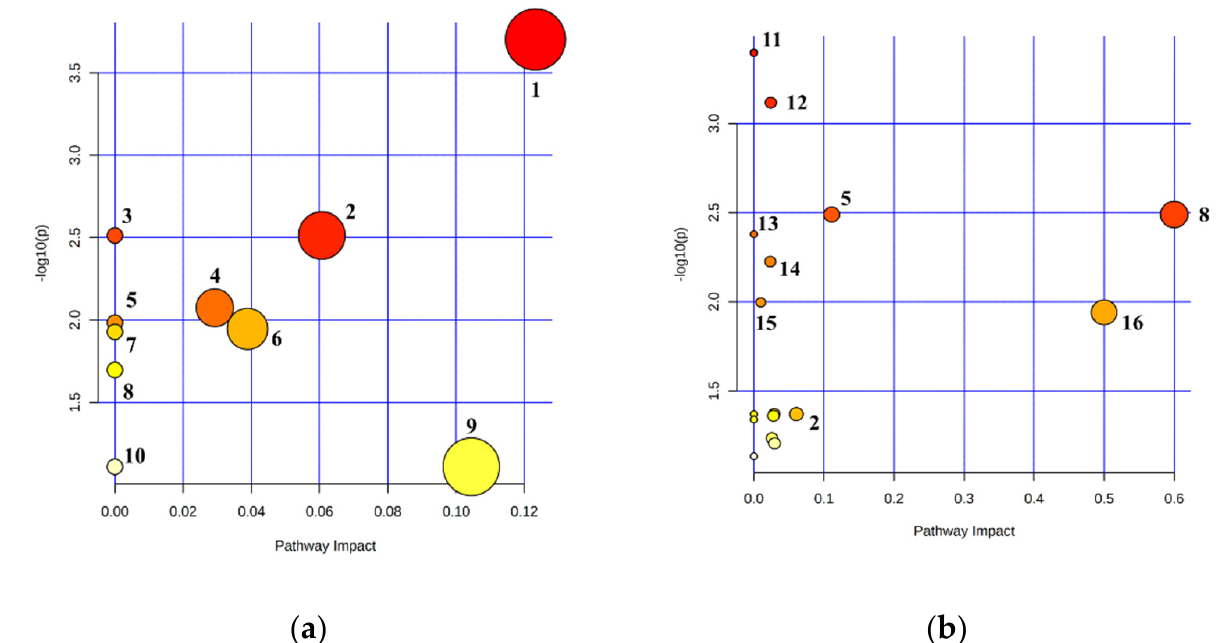
Figure 4. Metabolic pathway mapping was significantly different between rumen fluid ( a ) and milk ( b ) compared in healthy and subclinical ketosis groups. The pathway impact analysis was performed using the Metaboanalyst 5.0 program. The results are presented graphically as a bubble plot. The darker color and larger size represent higher p -value from enrichment analysis and greater impact from pathway topology analysis, respectively. Metabolic pathway name: 1, starch and sucrose metab-